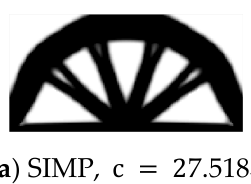
Figure 16. Optimization results of SIMP and BESO methods.